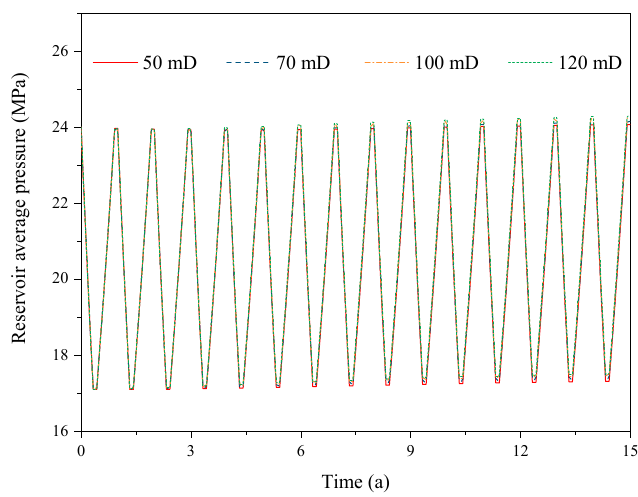
Figure 16. Reservoir average pressure for different reservoir horizontal permeability.